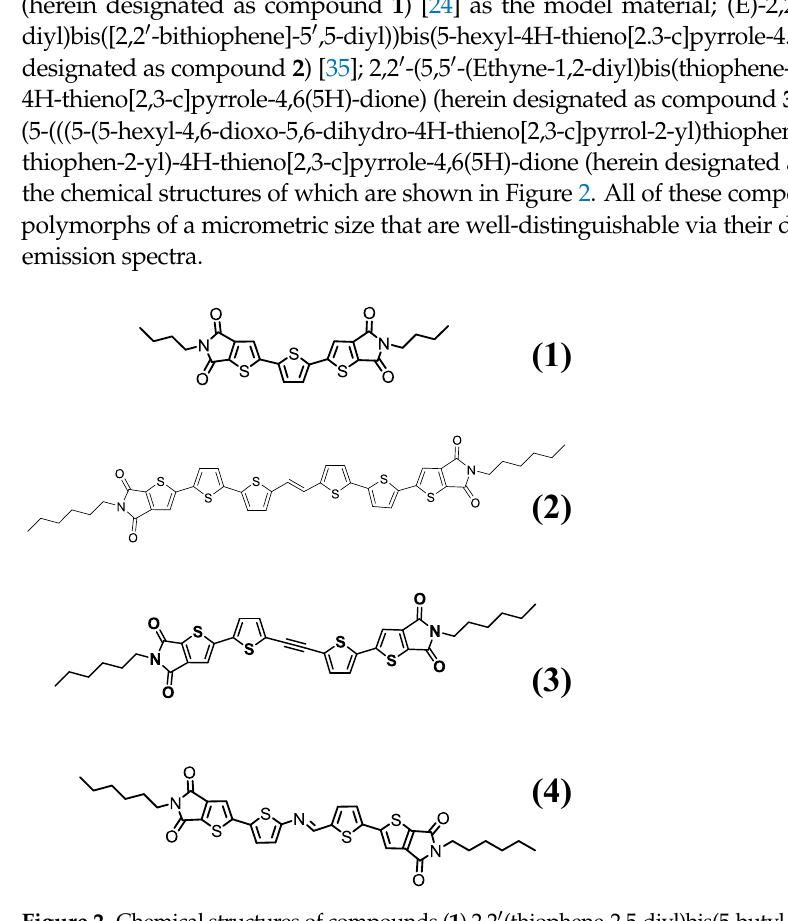
Figure 2. Chemical structures of compounds ( 1 ) 2,2 (cid:48) (thiophene-2,5-diyl)bis(5-butyl-5Hthieno[3,2-c]pyrrole- 4,6-dione); ( 2 ) (E)-2,2 (cid:48) -(5 (cid:48) ,5 (cid:48)(cid:48) ‘-(ethene-1,2-diyl)bis([2,2 (cid:48) -bithiophene]-5 (cid:48) ,5-diyl))bis(5-hexyl-4H-thienopyrrole- 4.6(5H)-dione); ( 3 ) 2,2 (cid:48) -(5,5 (cid:48) -(Ethyne-1,2-diyl)bis(thiophene-5,2-diyl))bis(5-hexyl-4H-thieno[2,3-c]pyrrole- 4,6(5H)-dione); and ( 4 )